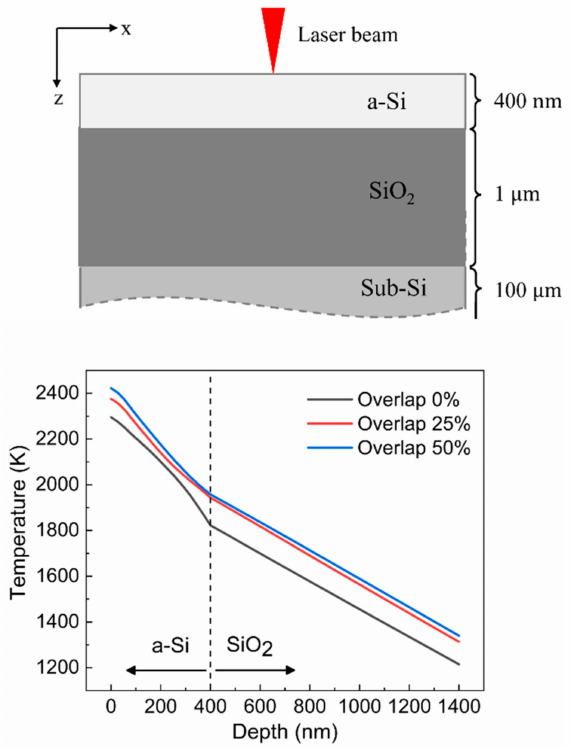
Figure 6. Cross-section of the computational domain and temperature distribution in the depth